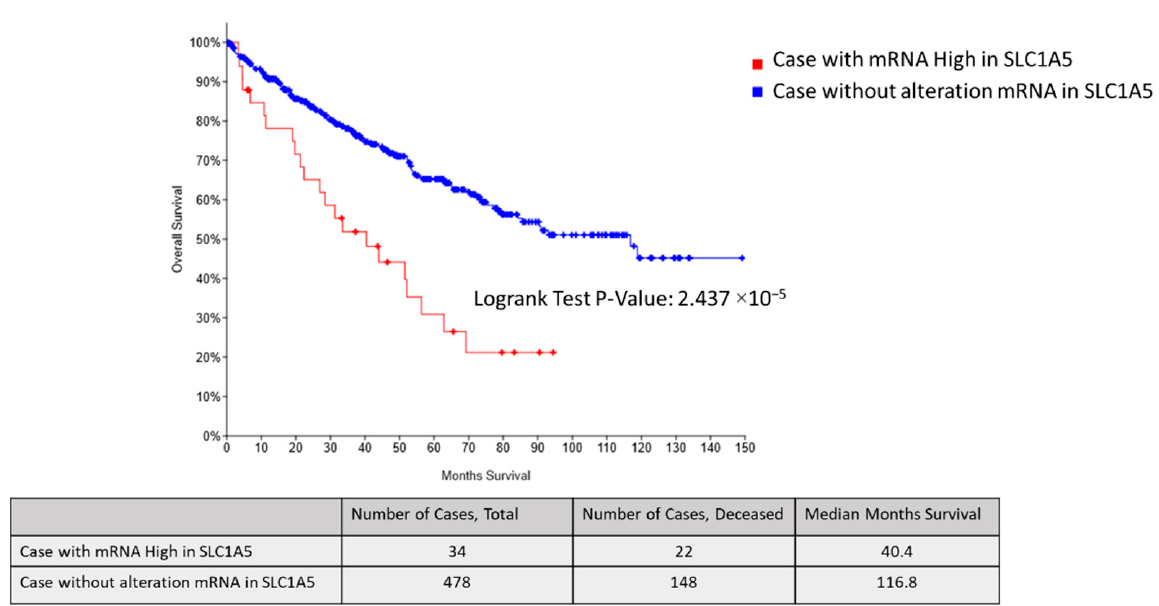
Figure 5. Kaplan–Meier survival plots for SLC1A5 mRNA high groups in a TCGA ccRCC cohort. Patients with high SLC1A5 mRNA expression (n = 34, red line) had significantly poorer overall survival compared with patients without altered SLC1A5 mRNA expression (n = 478, blue line) in ccRCC ( p = 0.00002).